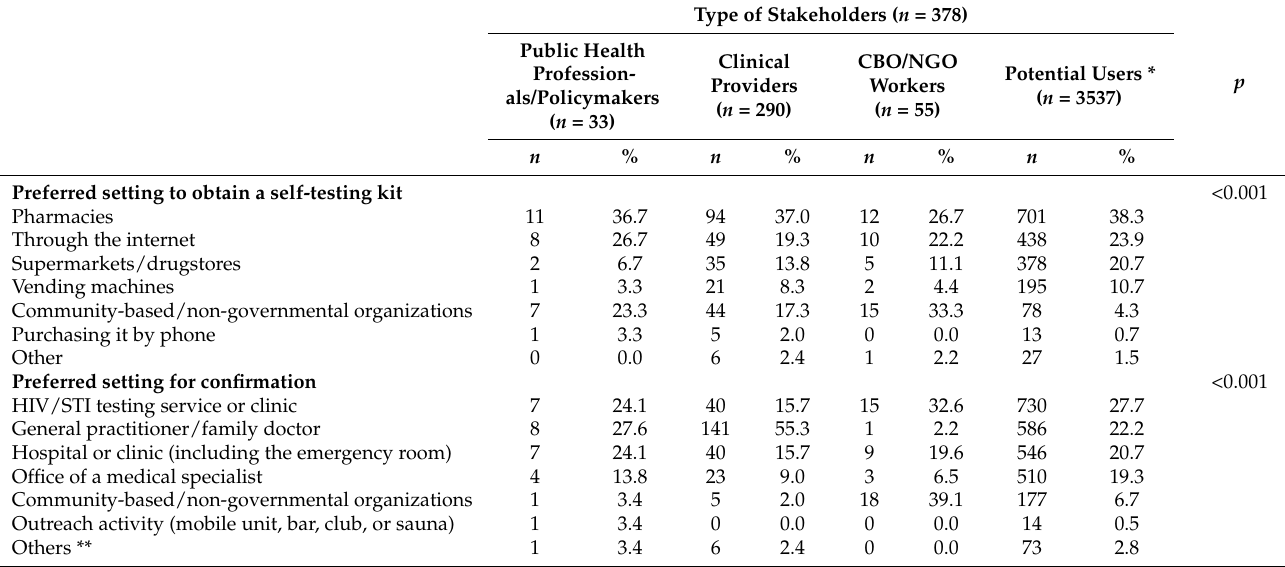
Table 4. Stakeholders’ opinions on the public’s preferred setting to obtain a kit and to confirm a reactive result vs. opinions of potential